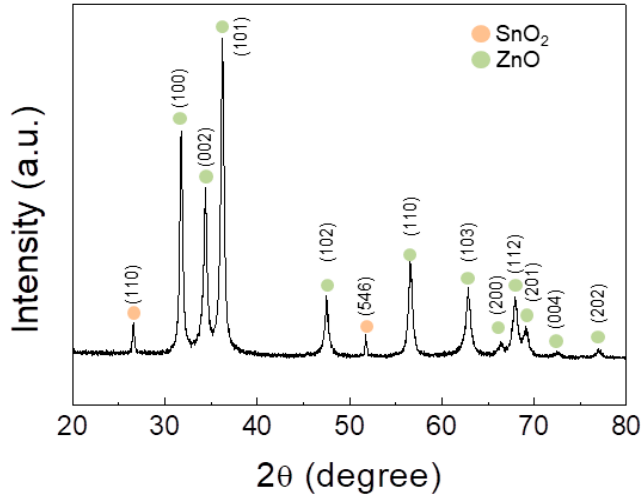
Figure 3. XRD pattern of the 0.1 SnO 2 ‐ loaded ZnO NFs.